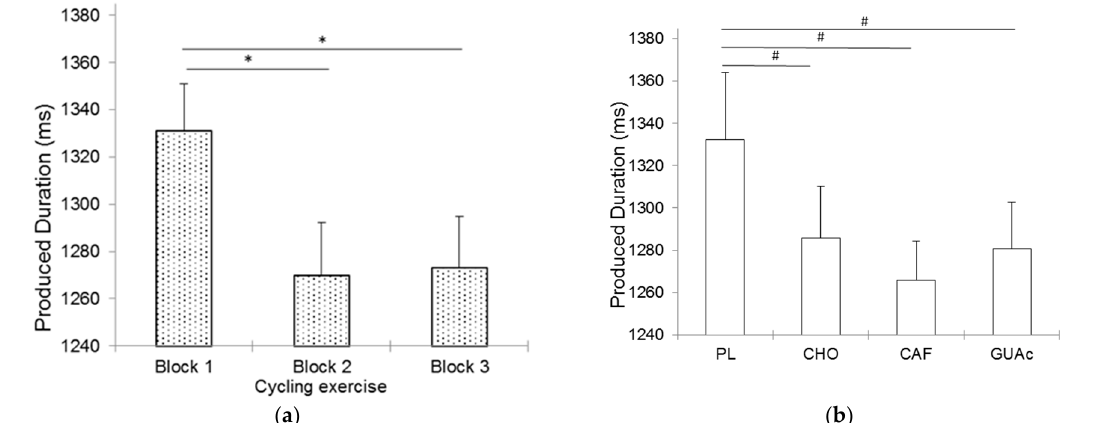
Figure 2. Mean produced durations as a function of exercise ( a ) and supplementation ( b ) Errors bars represent standard errors of the mean produced duration. * p < 0.05; # 75–95% likely different. Variance in Temporal